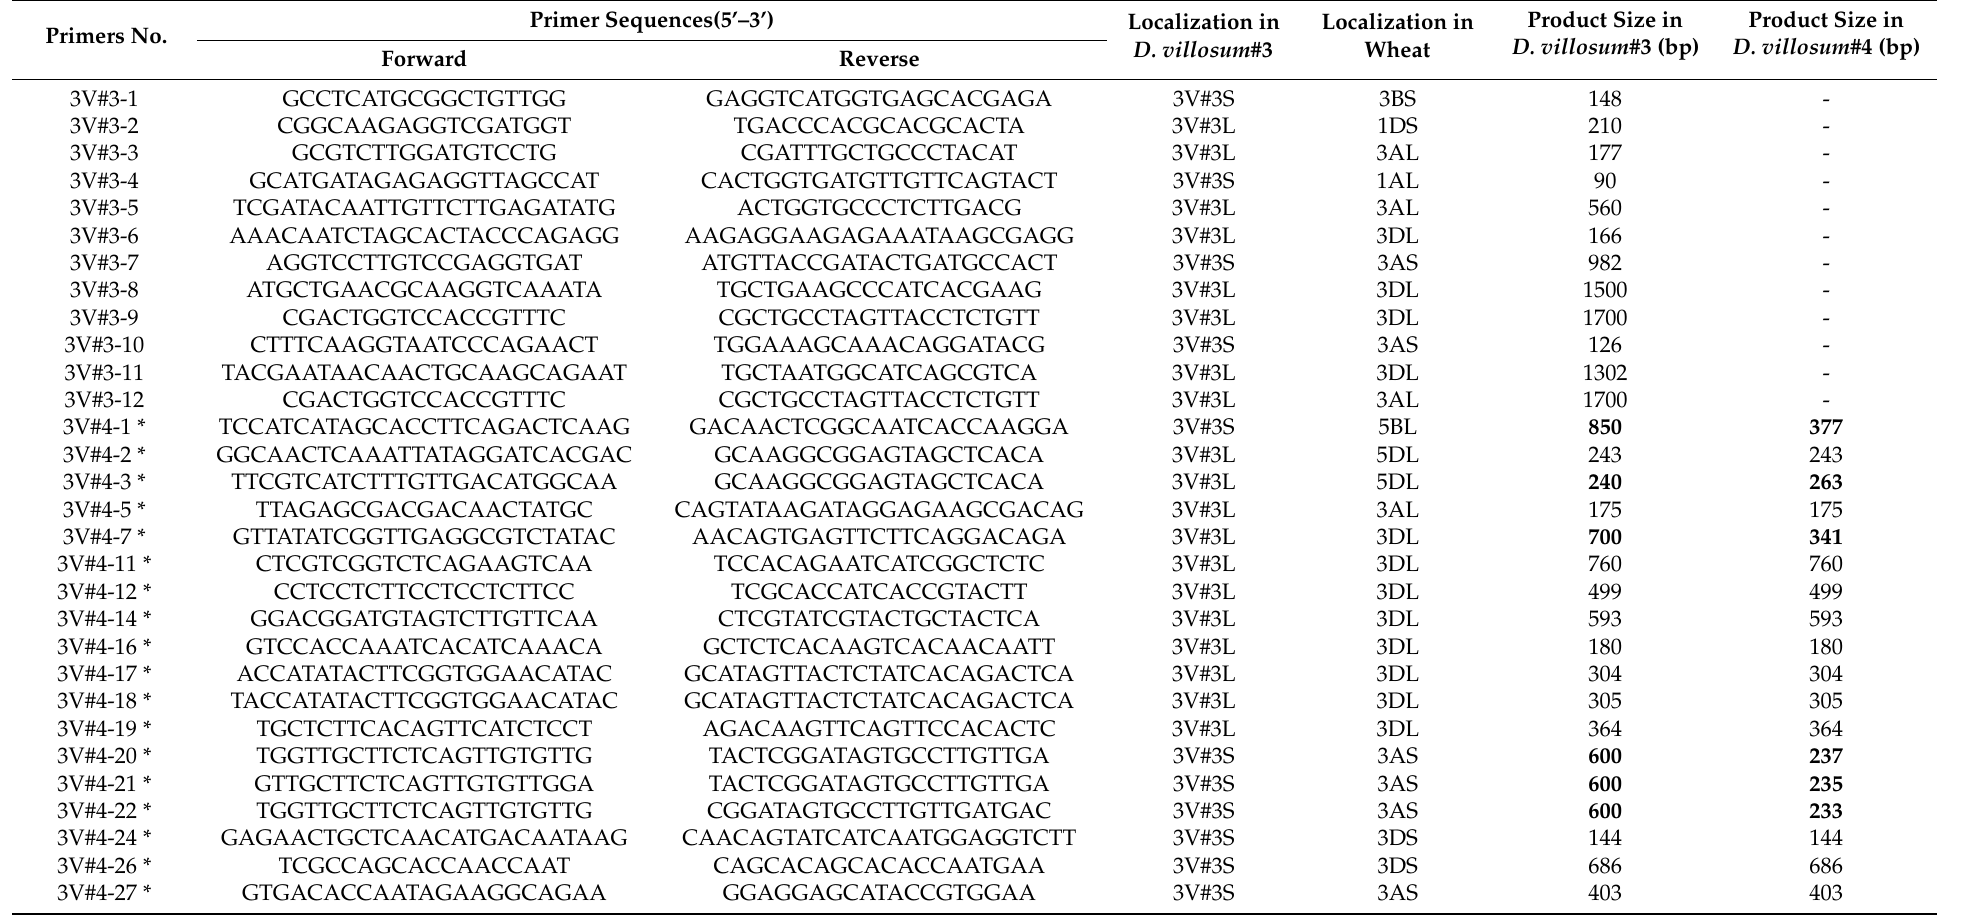
Table 2. Localization of the new markers and D. villosum# 4-specific markers in D. villosum#3 , their primer sequences and product sizes. Primers